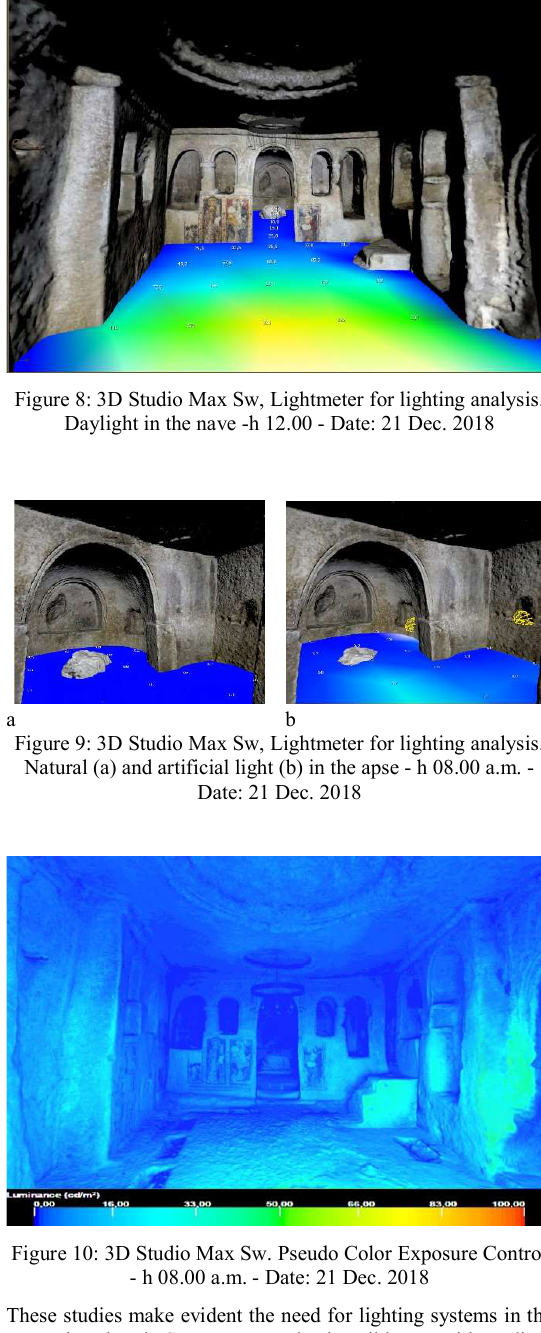
Figure 10: 3D Studio Max Sw. Pseudo Color Exposure Control - h 08.00 a.m. - Date: 21 Dec.